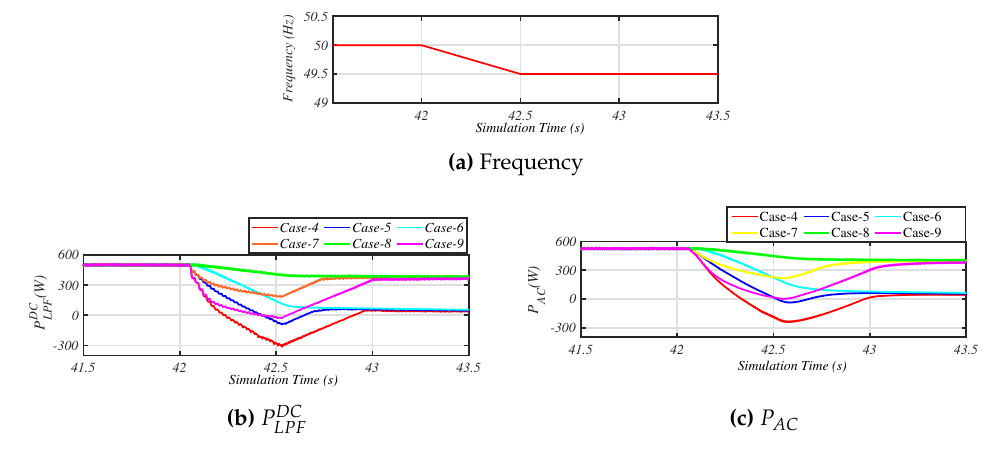
Figure 9. Modified VSHP measured test result.